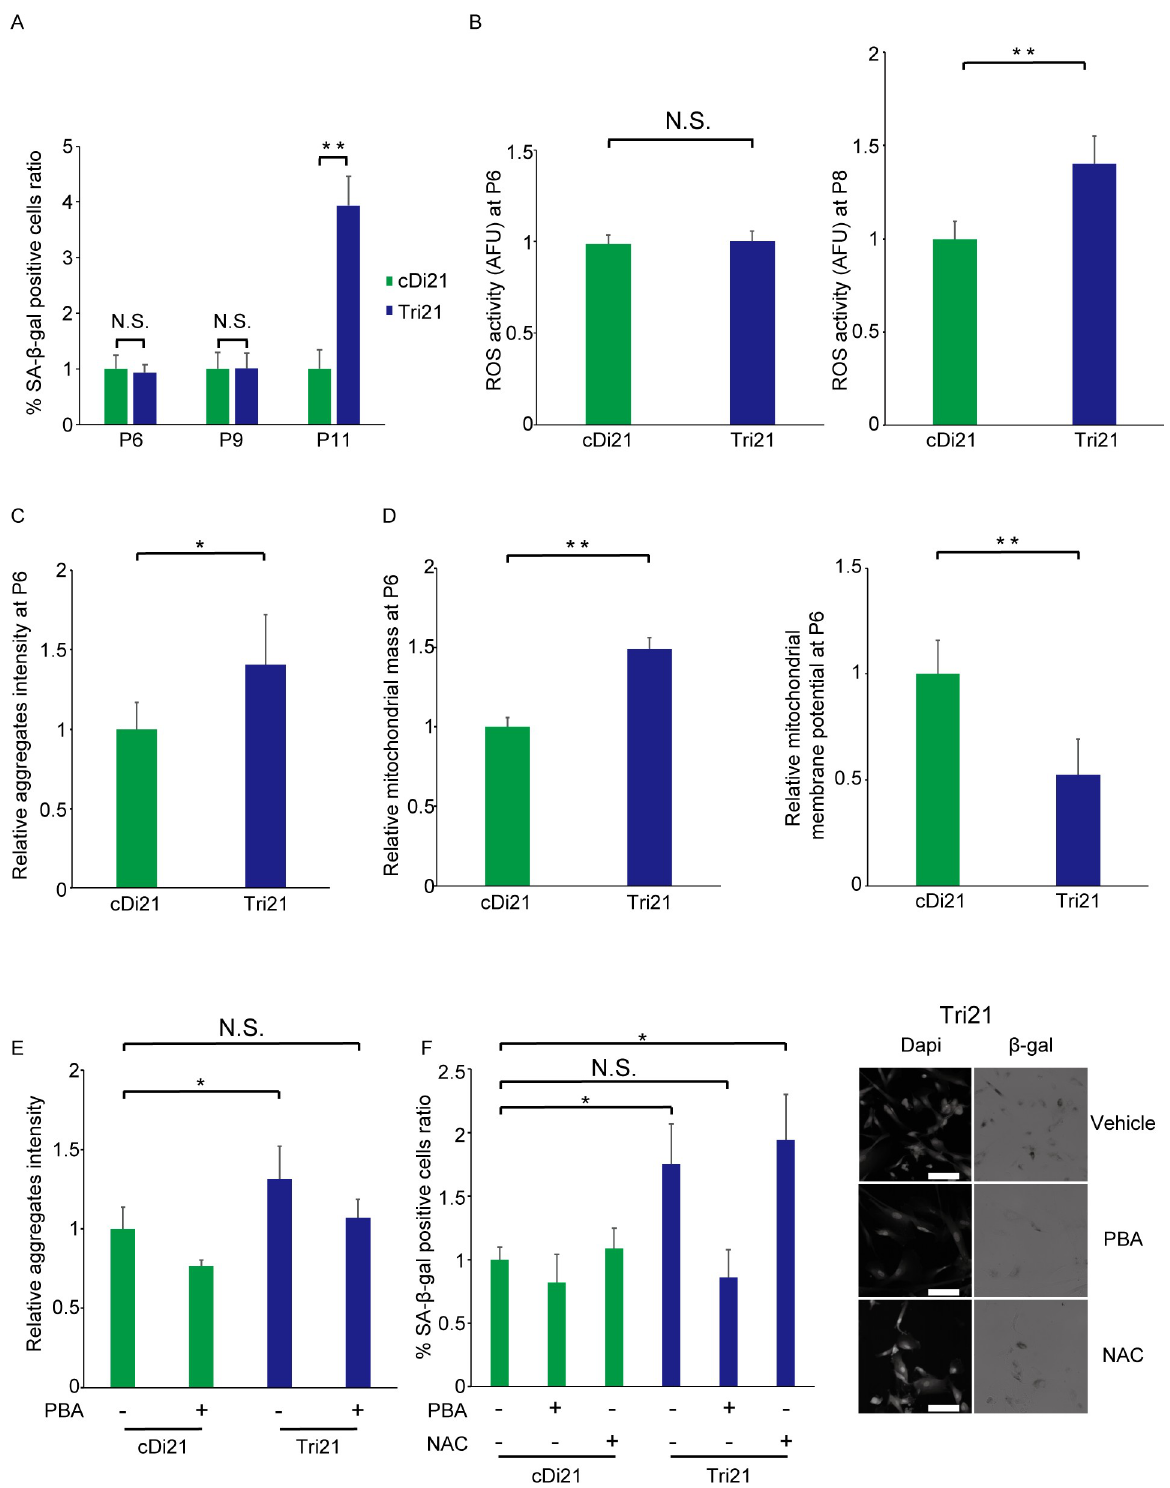
Fig 6. Rescue of trisomy-induced premature senescence by 4-PBA treatment in trisomy 21 iPSC-derived secondary fibroblasts. (A) Percentage of SA- β -gal-positive cells (n = 3 per cell line). �� P < 0.01. cDi21, corrected disomy 21 iPSC-derived secondary fibroblasts; Tri21, trisomy 21 iPSC-derived secondary fibroblasts; N.S., not significant. (B) Relative ROS production as expressed by relative MitoSOX/MitoTracker ratio at passage 6 (left) and passage 8 (right) (n = 6 per cell line). �� P < 0.01. cDi21, corrected disomy 21 iPSC-derived secondary fibroblasts;